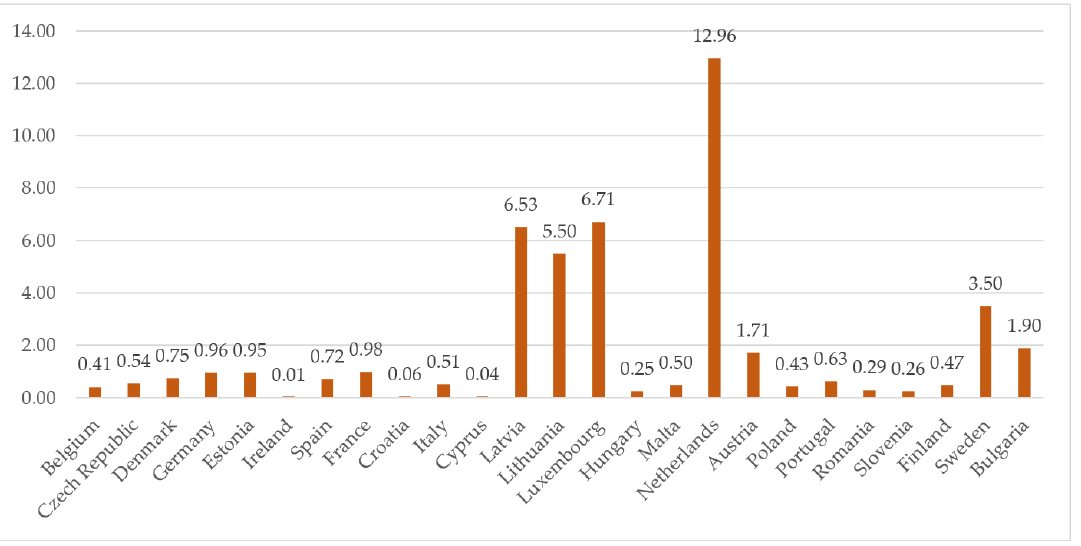
Figure 9. The share of electrical motor coaches, buses and trolley buses in EU countries in 2020, %. Note: the data for Greece and Slovakia are not available. Source: [74].